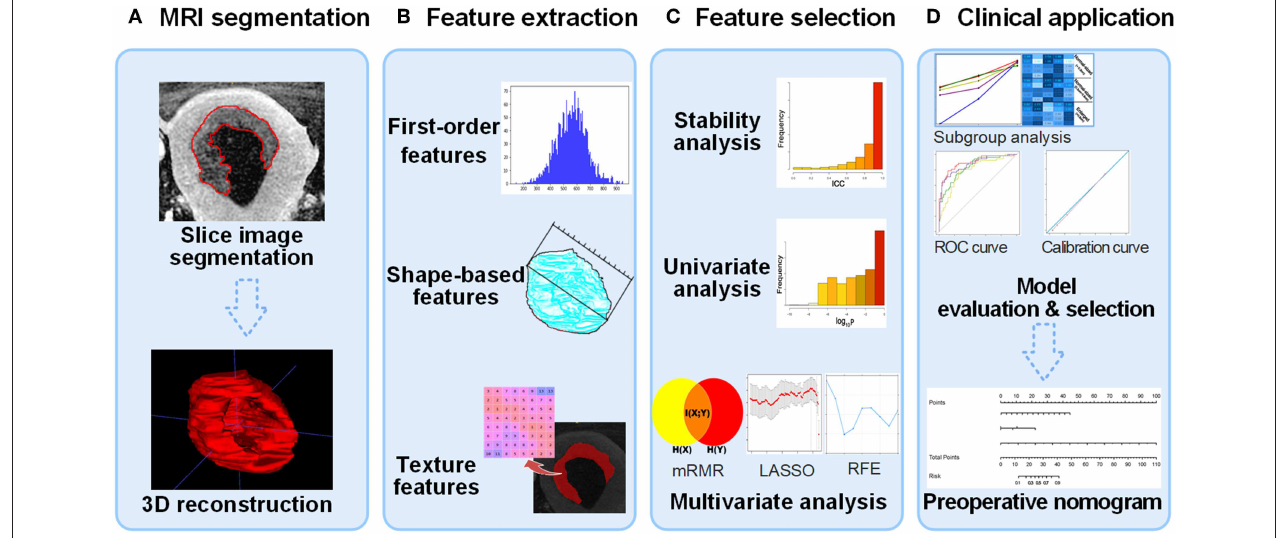
FIGURE 2 | Flow diagram of radiomic model construction. (A) MR images segmentation. The tumor region in each MRI slice was manually segmented, and then the whole tumor volume was reconstructed in order to extract 3D radiomic feature. (B) Radiomic feature extraction. Three types of radiomic features were extracted from tumor volume. (C) Feature selection process including stability, univariate analysis, and multivariate analysis. The construction of Model C starts from univariate analysis. (D) Clinical application. After evaluating the four models, an optimal model was selected to plot nomogram for clinical computer-assisted decision support. MRI, magnetic resonance image; 3D,